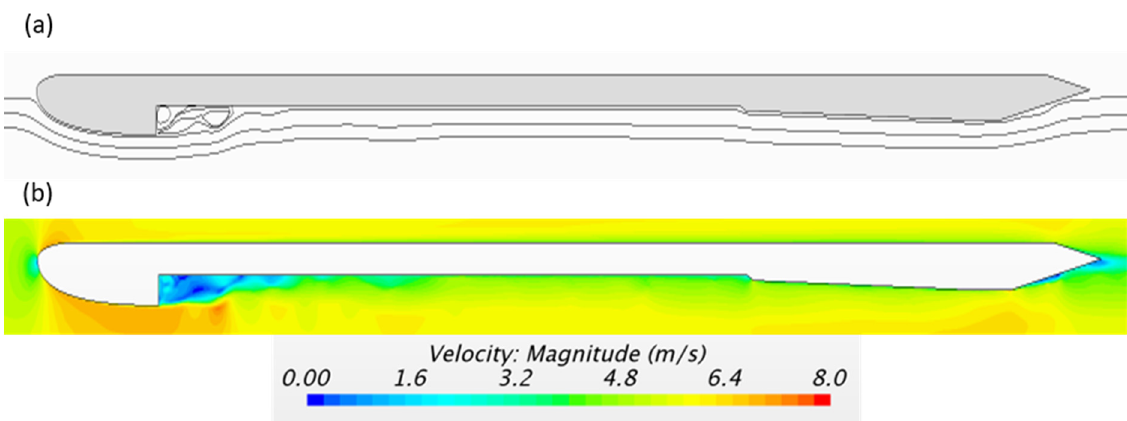
Figure 8. ( a ) Streamlines and ( b ) velocity magnitudes in the state close to complete air-cavity collapse (as in Figure 7b) at q = 0.010 and U = 5.4 m/s. Vertical dimensions are scaled up two times for clarity.